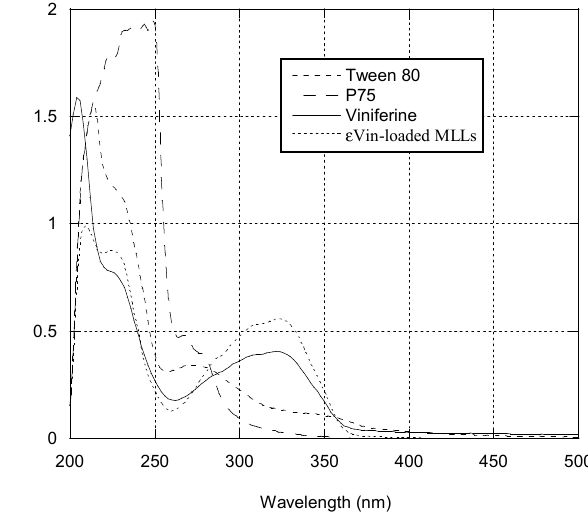
Figure 3. UV-vis spectrum of ε Vin (10 µg mL − 1 in MetOH), ε Vin-loaded MLLs after destruction in MetOH:water (1:1) with ε Vin concentration of 5 µg mL − 1 , P75 in MetOH:water (1:1) (1 mg mL − 1 ), and Tween 80 in MetOH:water (1:1) (8 mg mL − 1 ).